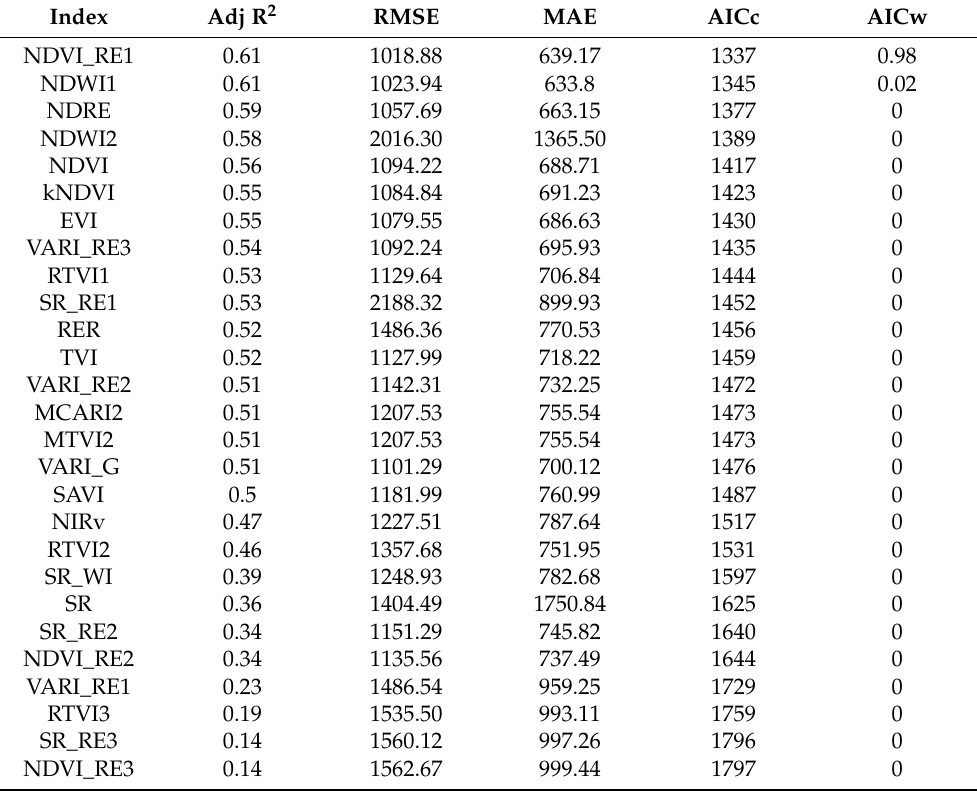
Table 3. Results of log-linear regression models predicting cover crop aboveground biomass, includ- ing the coefficient of determination (adjusted R 2 ), root mean square error (RMSE), and the mean absolute error (MAE), and model fit statistics—Akaike’s information criterion for small sample sizes (AICc) and AIC weights (AICw). Refer to Table 1 for optical index abbreviations. Log-linear models best met parametric assumptions. The red-edge normalized difference vegetation index with band 5 (NDVI_RE1) best estimated winter cover crop